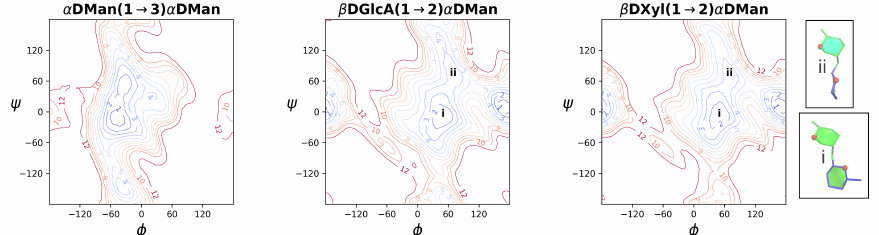
Figure A1. Contoured 2D φ , ψ PMF surfaces for disaccharide in the gas phase illustrate the range of motion possible for an unrestrained linkage: α D Man(1 → 3) α D Man ( left ); β D Glc(1 → 2) α D Man ( middle ); and β D Xyl(1 → 2) α D Man ( right ). Contours are drawn at intervals of 1 kcal.mol − 1 to a maximum of 12 kcal.mol − 1 . The β (1 → 2) PMF maps are annotated with the φ , ψ regions associated with the (i) major “face-on” and (ii) minor “side-on” linkage orientations. The insets show schematics of the relative rotations of the glycosidic rings in these two